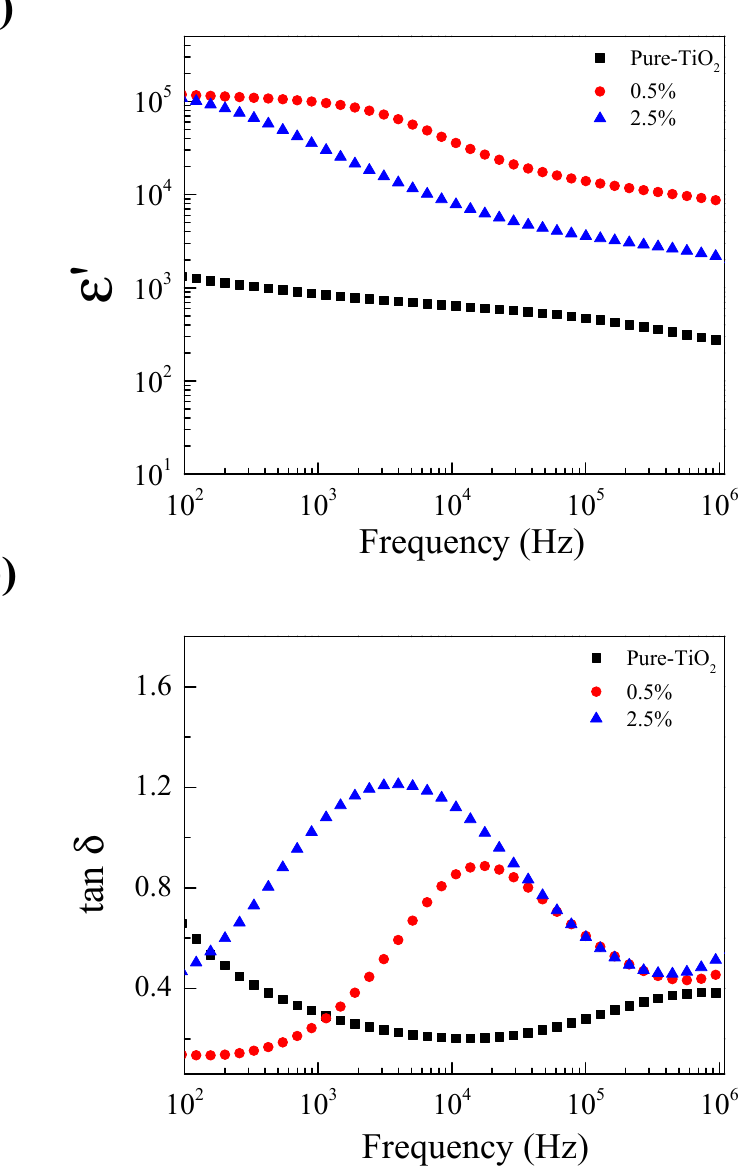
Figure 5. Frequency dependence of ( a ) ε′ and ( b ) tan δ at RT for ZNTO ceramics with various codopant concentrations ( x = 0.5%, 0.25%).